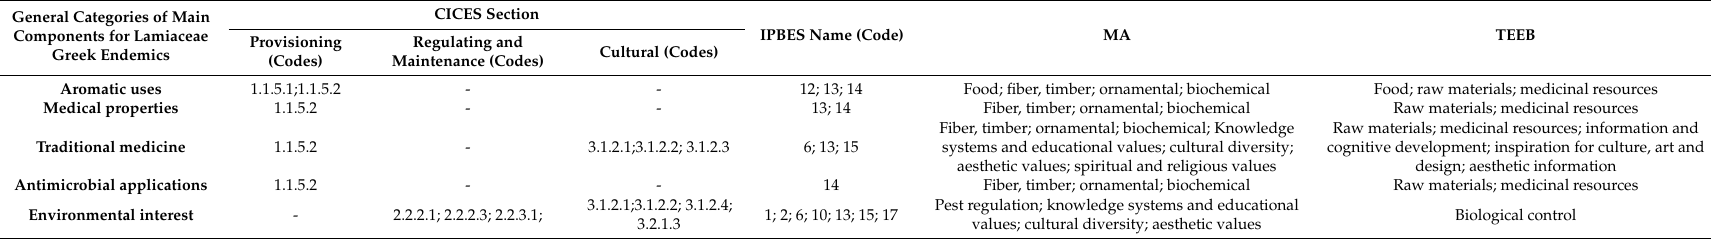
Table 4. Correspondence of the general (summarizing) categories of the Lamiaceae Greek endemics to the CICES categories and the relevant ecosystem services categories of IPBES, MA and